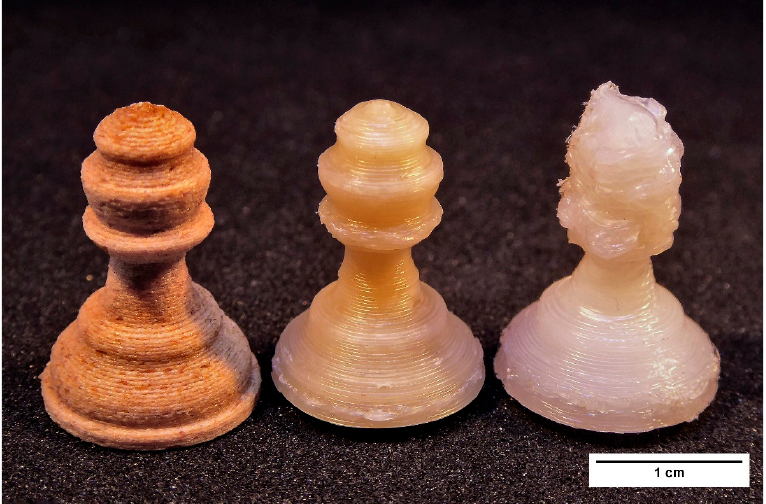
Figure 9. Three-dimensional printed models: filament used on the left pawn is Woodfill, HDPE for the middle and CNF-PSA/HDPE composite for the right one.